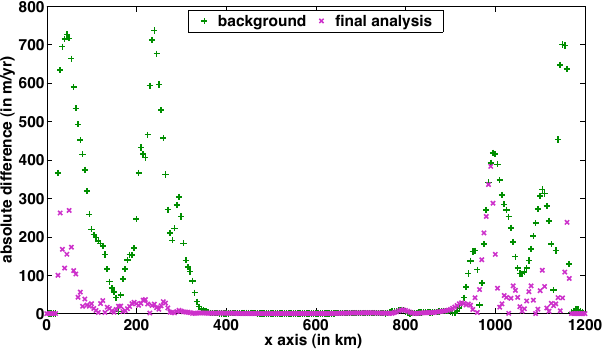
Fig. 14. Absolute difference between final analysis mean (purple x) or background (green crosses) and reference sliding component of surface velocity after 20 years of the 1000-member ETKF with a slight inflation of 1.01.